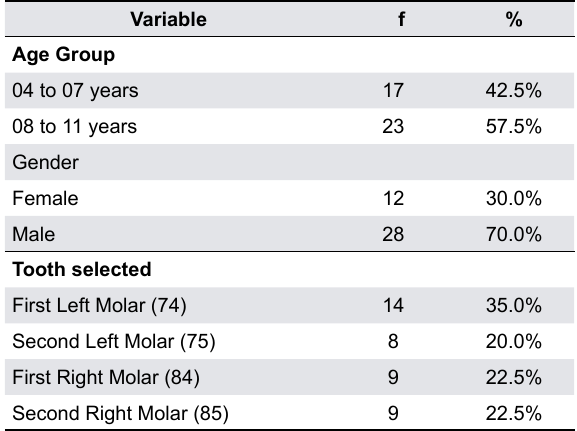
Table 1- Demographic characteristics of the patients and samples included in the